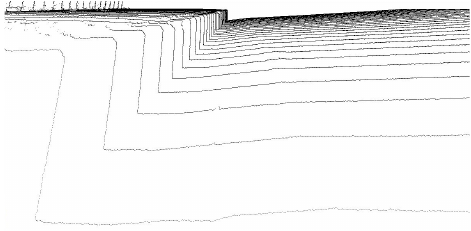
Figure 1: The difference of point density according to the direc- tion.